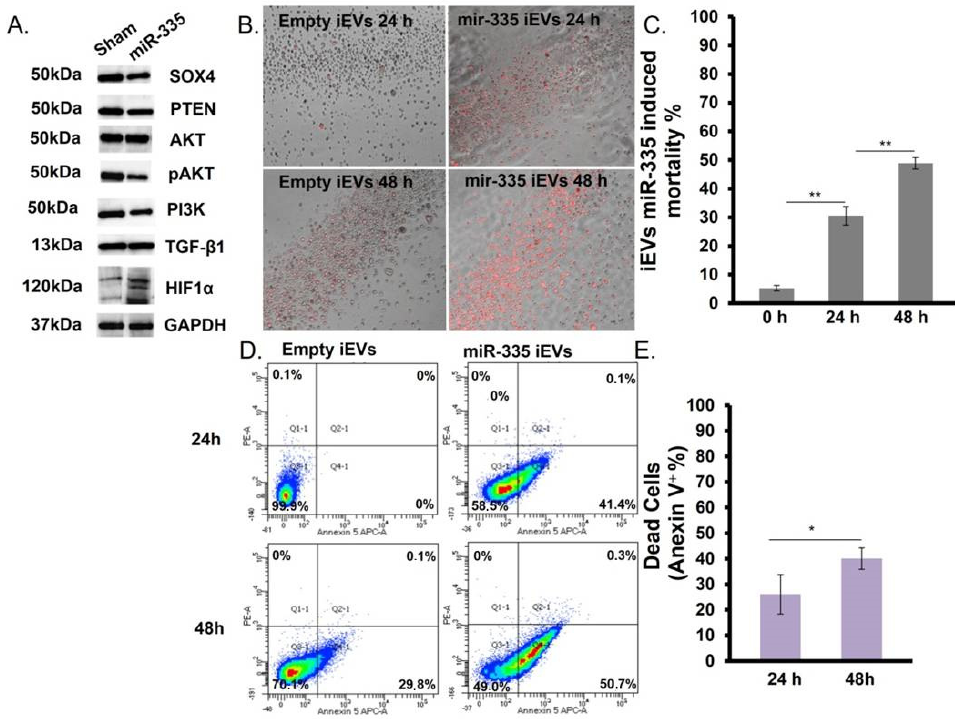
Figure 5. miR-335-laden iEVs modulate SOX4 and drive apoptosis in U266B1 cells. ( A ) Western blot analysis of protein levels in U266B1 cells after 24 h co-culture with iEVs. ( B ) Fluorescence microscopy of Annexin V (red)-positive cells: empty iEVs and miR-335-laden iEVs were incubated for 24 or 48 h with U266B1 cells at the following ratio (4 × 10 5 iEVs/cell). The image represents the merge of bright field and fluorescence (Tric). ( C ) Quantification of the effect (cell death) of miR-335-laden iEVs on U266B1 cells. ( p < 0.005 = ** evaluated by t -test). ( D ) Example of flow cytometry analysis of cell death (Annexin V positivity). ( E ) Quantitation of cell death in U266B1 cells treated with miR-335-laden iEVs. Results refer to the mean ± SD of three independent experiments. Statistical analysis was performed using normalized values, and by setting the threshold on empty vesicle-treated cells. ( p < 0.05 = * evaluated by t